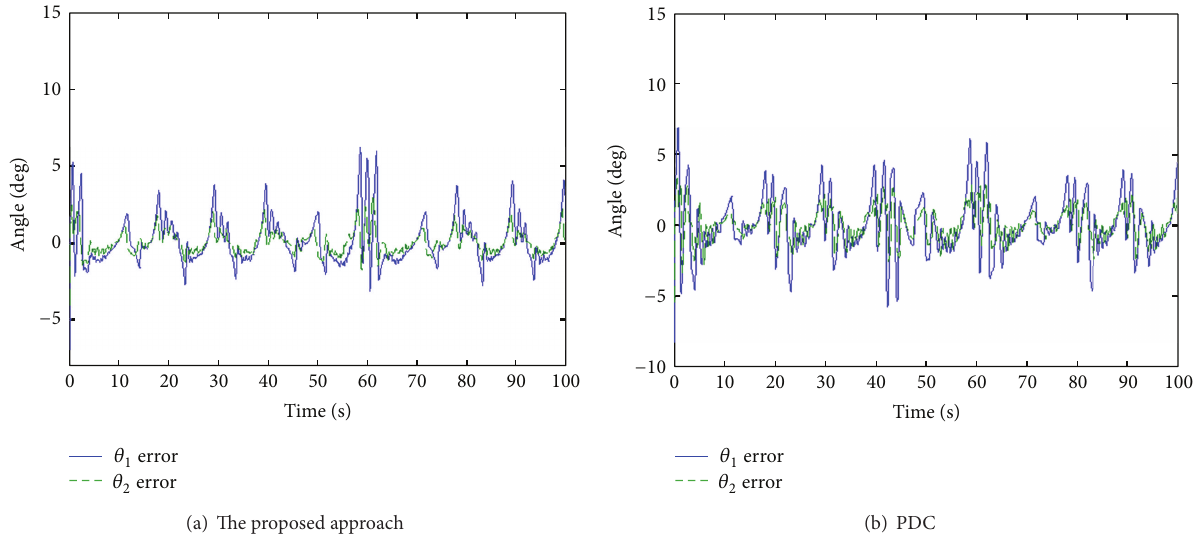
Figure 7: Angle tracking errors for both the proposed approach and PDC.